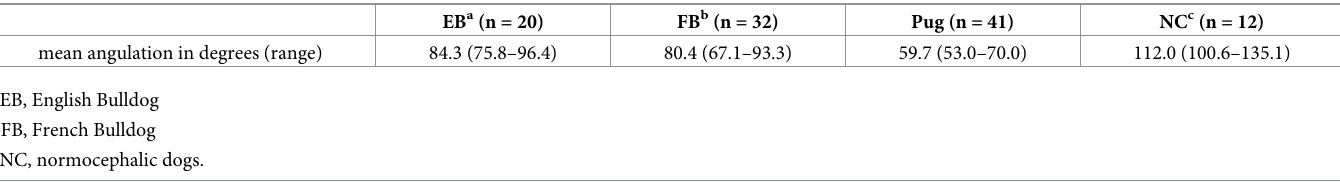
Table 2. Angulation of the nasolacrimal drainage system in 10 English Bulldogs bilaterally, 17 French Bulldogs (15 bilaterally, two unilaterally), 22 Pugs (19 bilater- ally, three unilaterally) and six normocephalic dogs (bilaterally in all cases). Measurements of NDS angulation revealed mean degrees of 84.3 in English Bulldogs, 80.4 in French Bulldogs, 59.7 in Pugs, and 112.0 in normocephalic